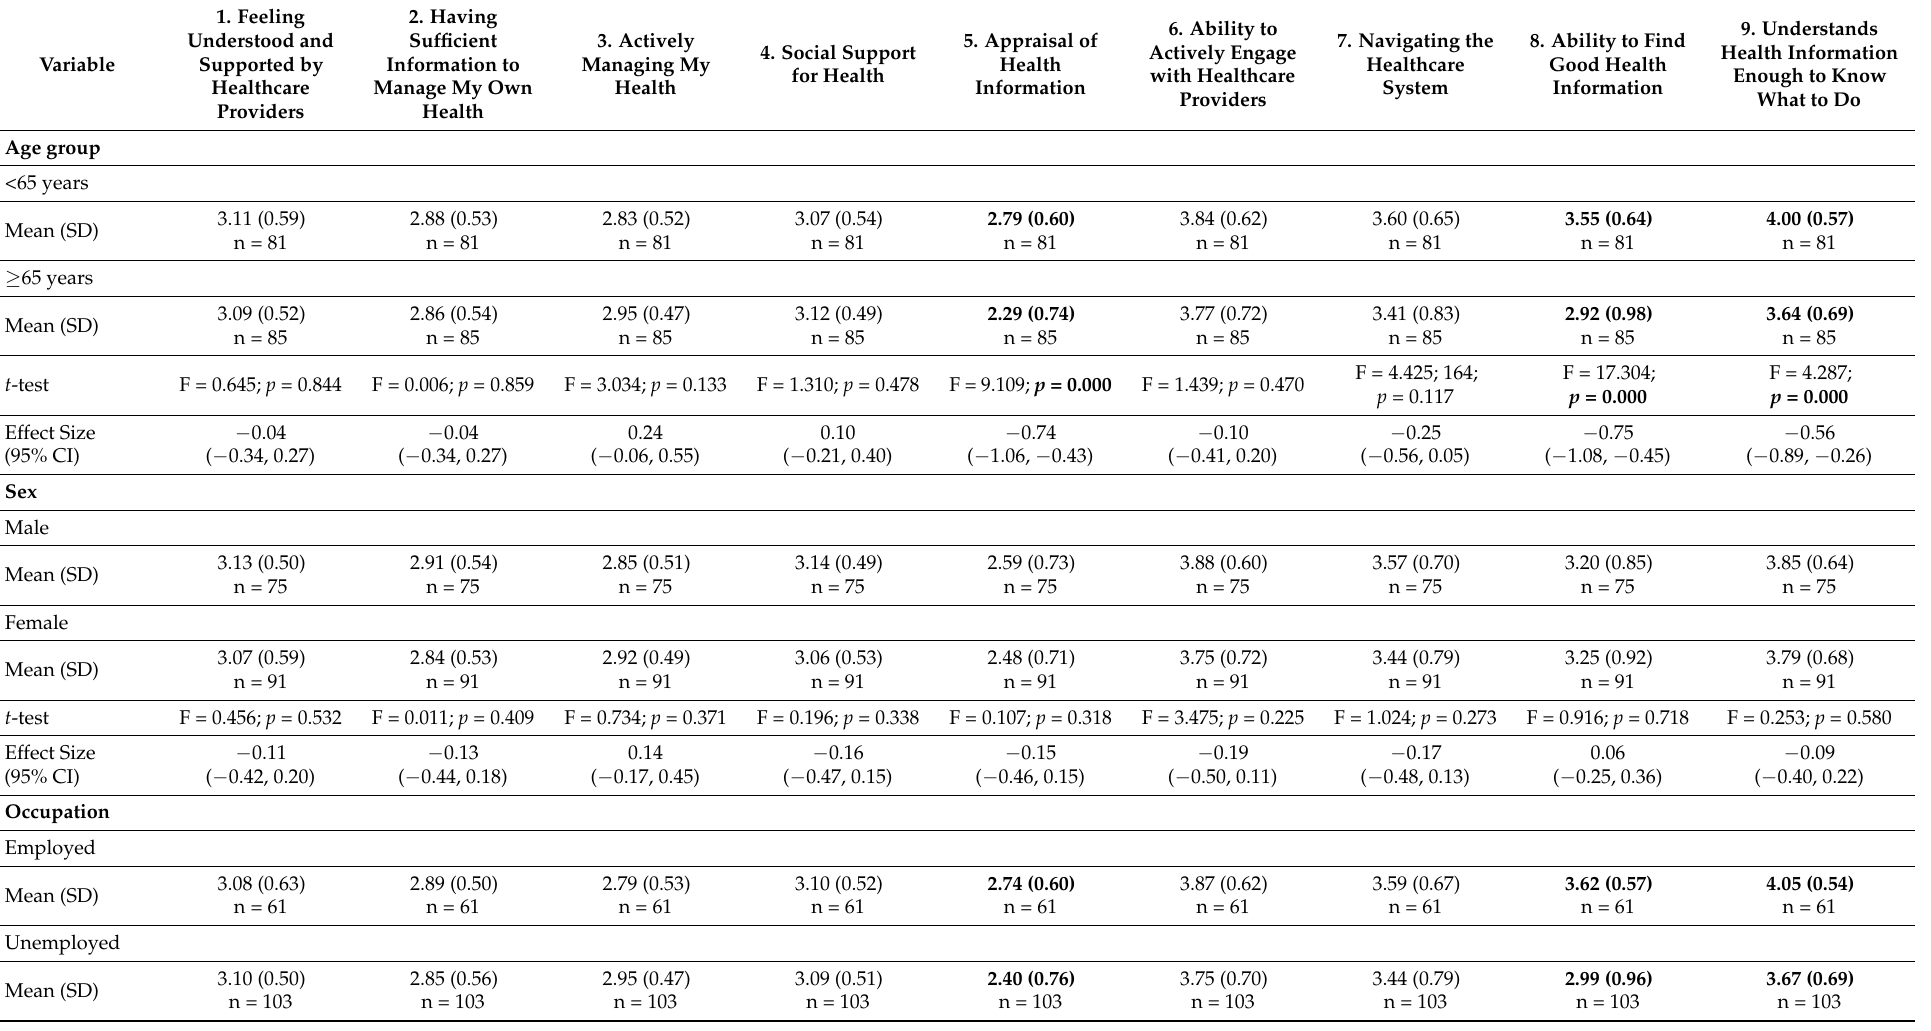
Table 1. Relationship between sociodemographic variables and HLQ